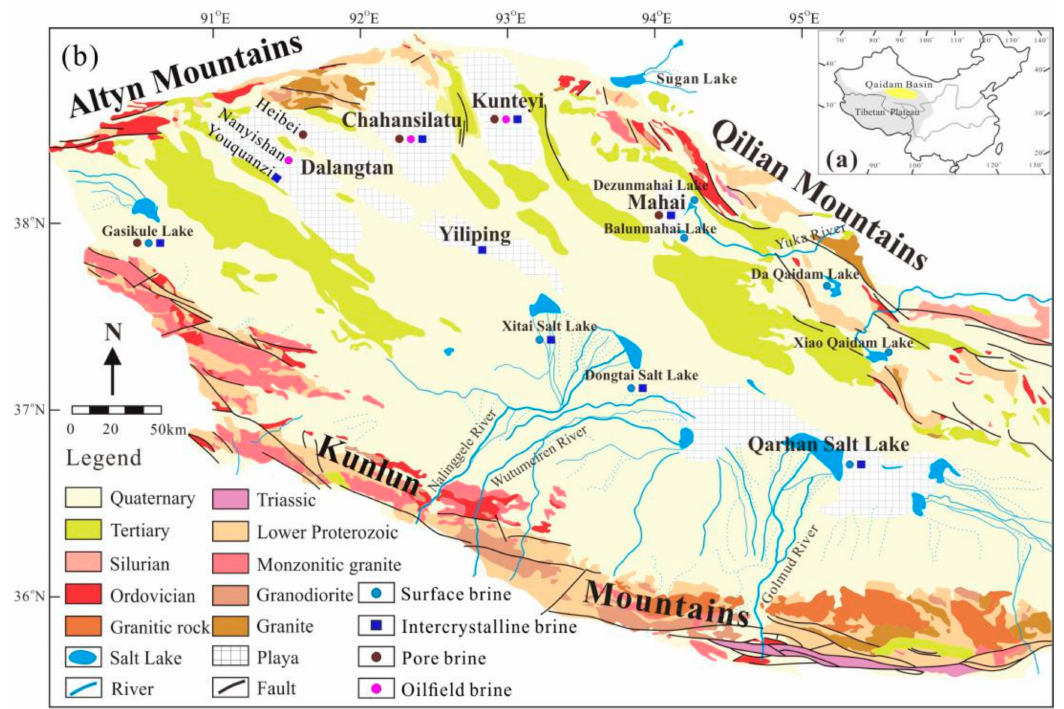
Figure 1. Geological map showing the study area: ( a ) the location of the Qaidam Basin (QB) in China; ( b ) geological map of the QB and its surrounding